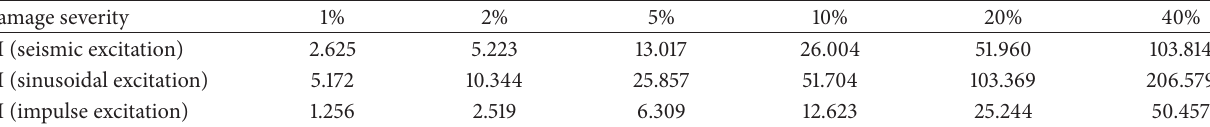
Table 2: Variations of damage index with damage severity.